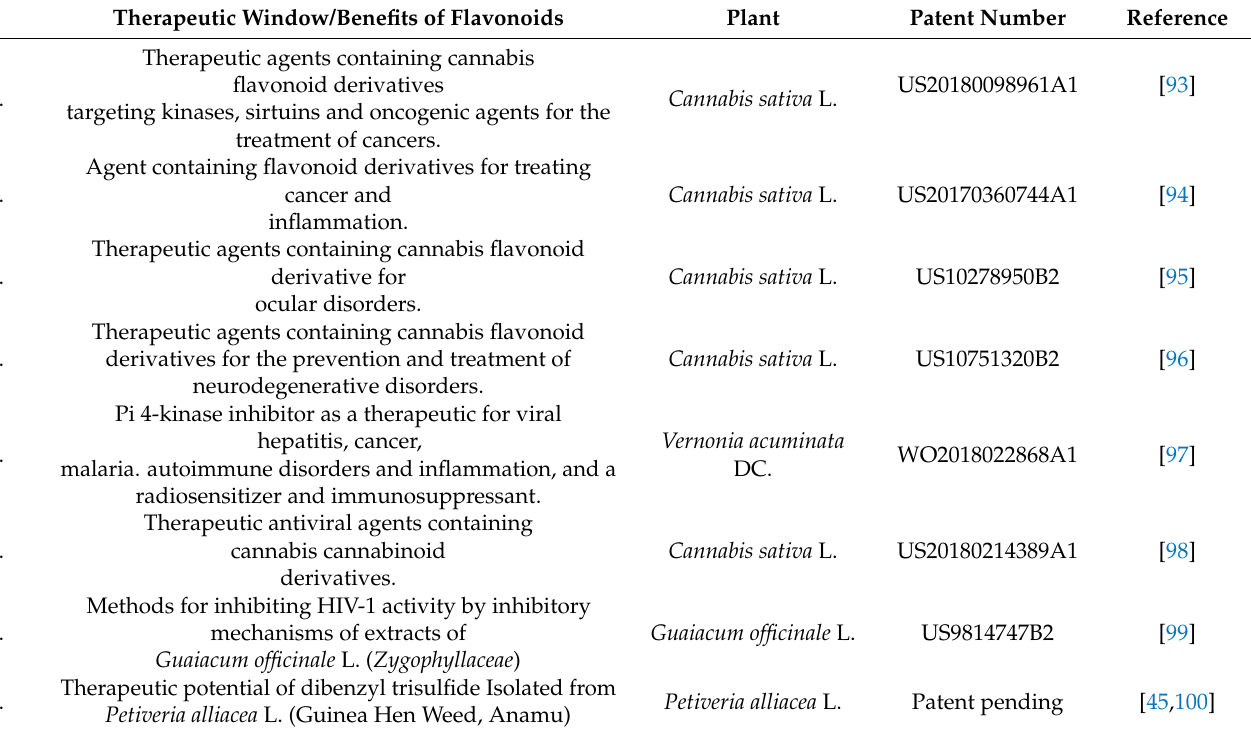
Table 4. Examples of patents on Jamaican Medicinal